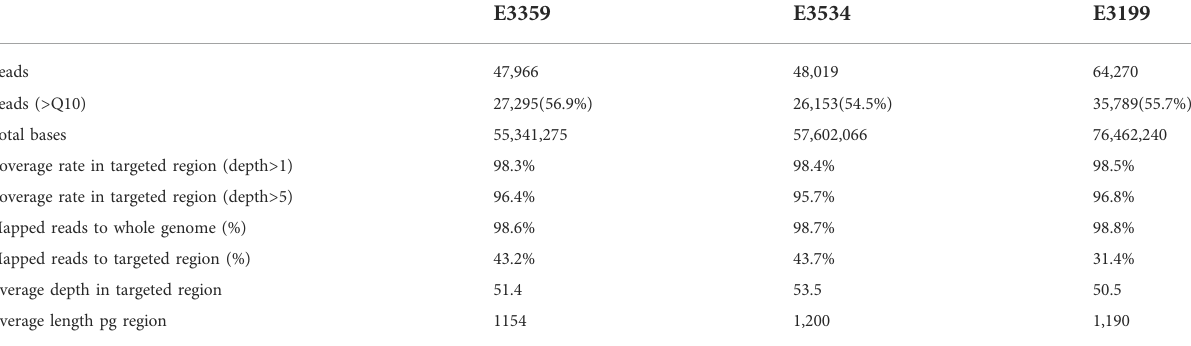
TABLE 1 Sequencing